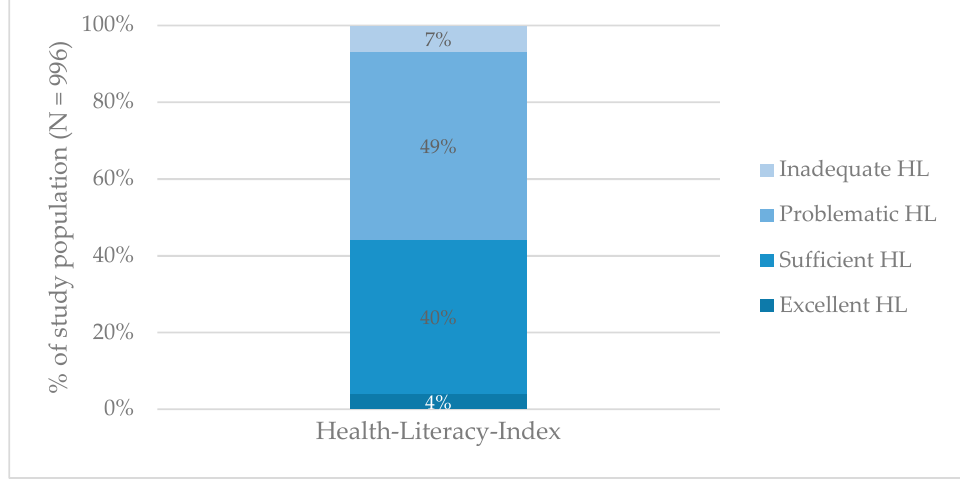
Figure 1. Health literacy (HL) levels among the study population .